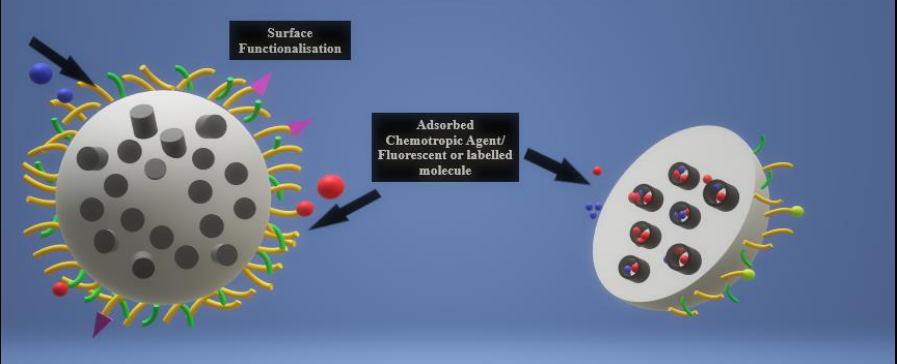
Figure 2. Illustration of a functionalization of a mesoporous silica nanoparticle. MSNs may be functionalized on the outer surface with targeting ligands or polymers for enhanced biocompatibility, while the inner pores may be loaded with chemotherapeutic agents, drugs, genetic components or fluorescent/labeled molecules for easy imaging.